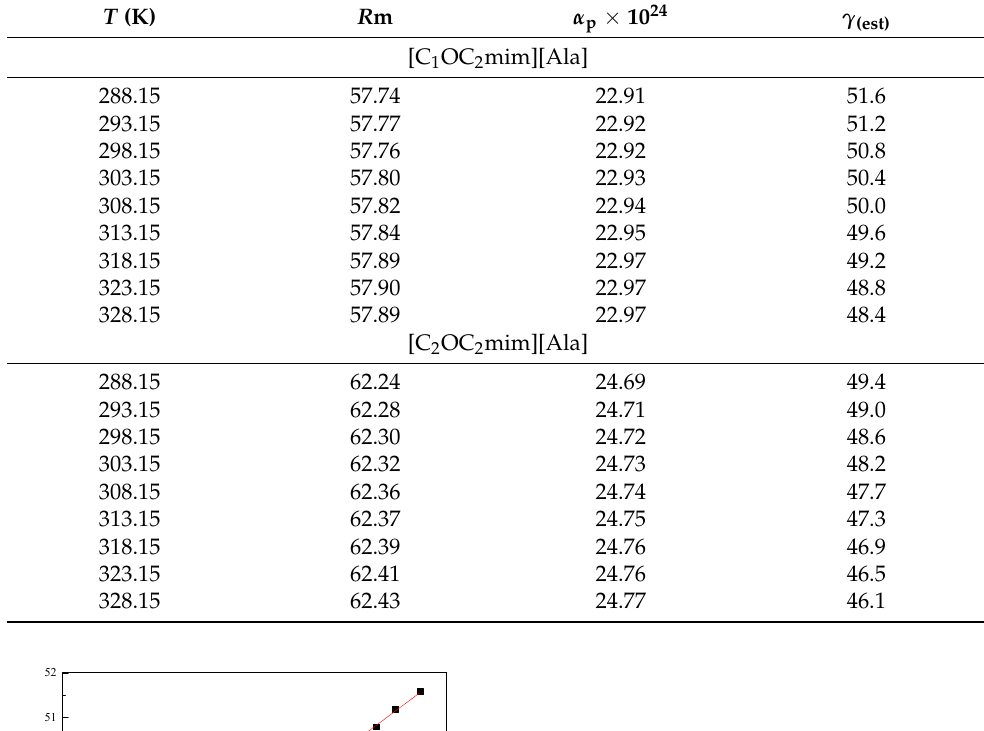
Table 3. Molar refraction ( R m ), mean molecular polarizability ( α p ), and estimated surface tension